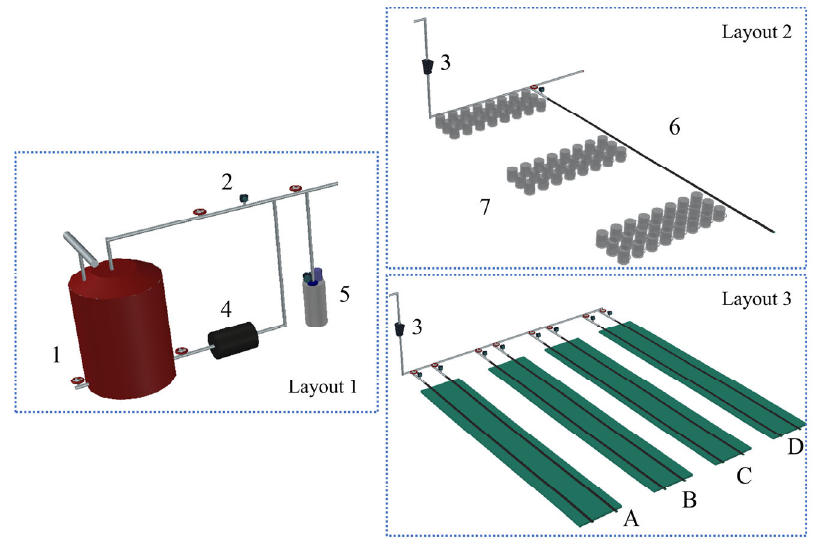
Figure 2. Test system layout. For the purpose of description, the test apparatus and system were divided into three parts. The laboratory test consisted of Layout 1 and Layout 2. The system of field experiment consisted of Layout 1 and Layout 3. 1. water supply tank; 2. pressure sensor; 3. filter; 4. water pump; 5. self-made herbicide application device; 6. untested microsprinkler hose; 7. measur- ing cups.